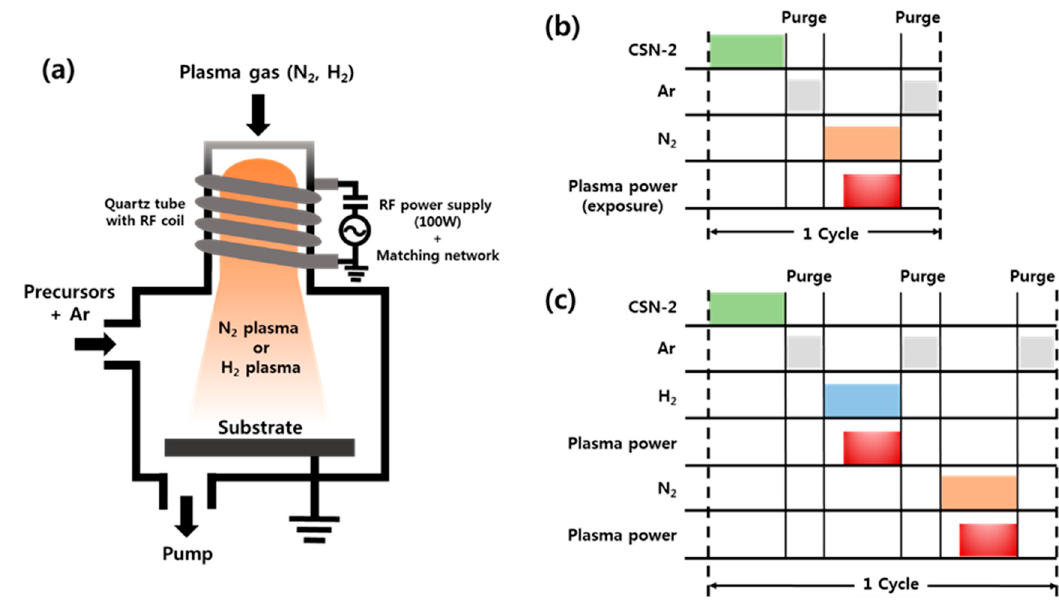
Figure 1. Schematic images of the ( a ) remote plasma atomic layer deposition (RPALD) system and process sequence ( b ) without H 2 plasma and ( c ) with H 2 plasma.